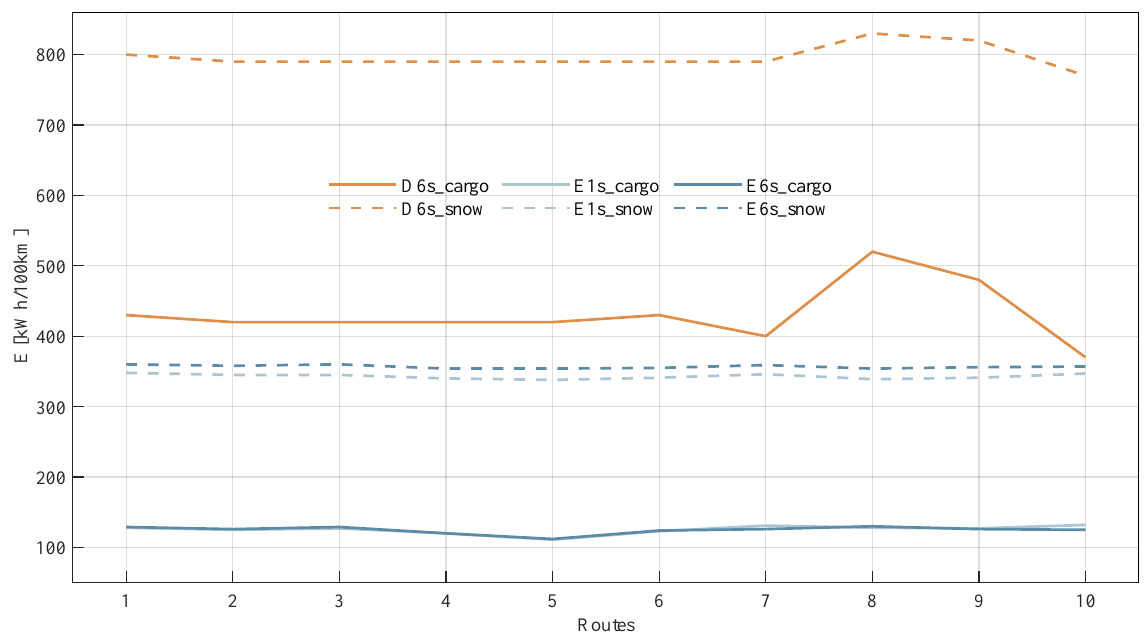
Figure 15. Simulated average consumptions where diesel consumption values are converted to kWh/100